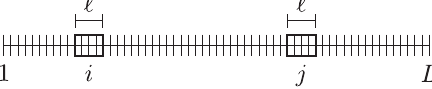
FIG. 2. Cells around sites i and j in the mesoscopic system corresponding to single sites in the coarse-grained description. The toy model Q-SSEP seems to be a good candidate for such a coarse-grained description. Noise emerges by averaging the mesoscopic system over all unitary transformations that only act on the individual cells, and it conserves the number of particles inside each